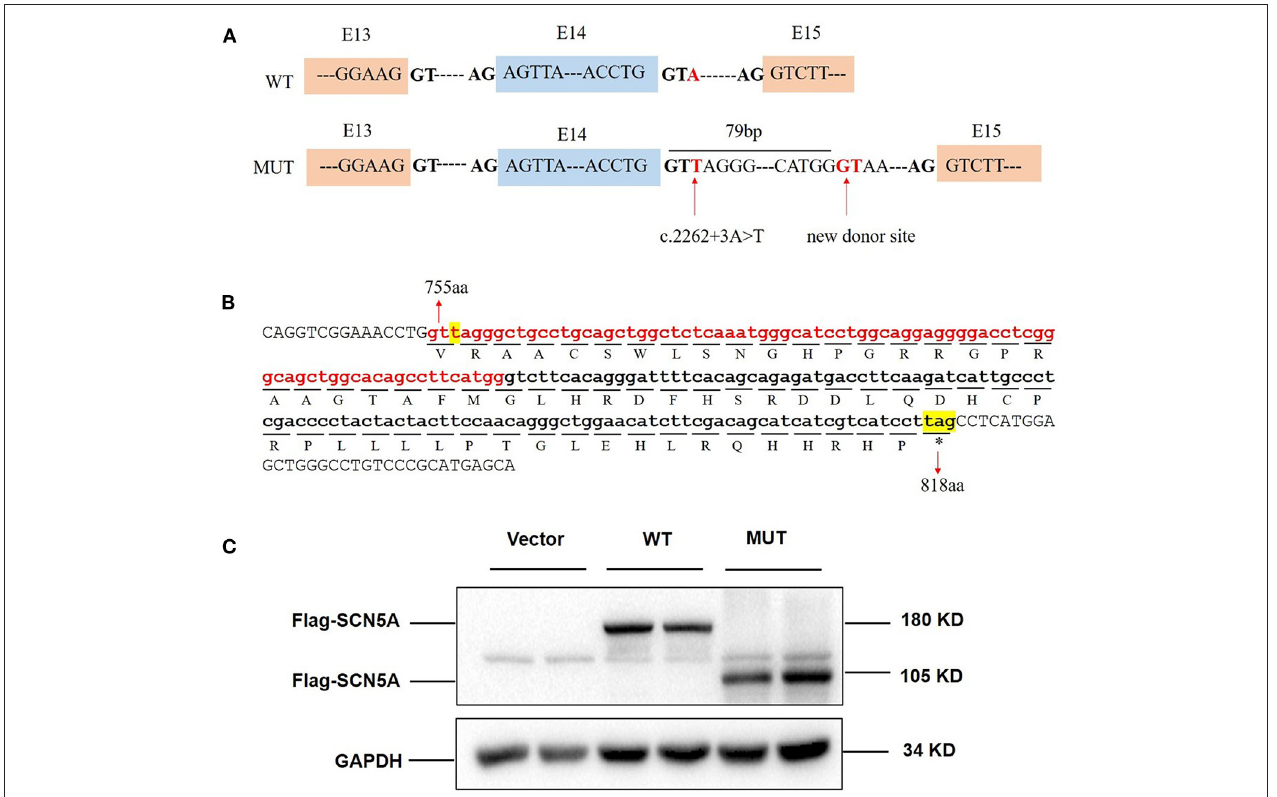
FIGURE 4 | c.2262 + 3A > T variant caused protein truncation. (A) Exon 14 and adjacent structures in the SCN5A gene. The arrow shows the location of the splice site variant c.2262 + 3A > T and new donor site in intron 14. (B) Consequence of the c.2262 + 3A > T variant at the amino acid level. The retained 79 bp caused the addition of 63 amino acids followed by a premature stop codon at position 818. The protein translation is shown below the nucleotide sequence in the one-letter amino acid code. (C) SCN5A protein expression in whole HEK293 cells transfected with vector, wild-type, and mutant SCN5A